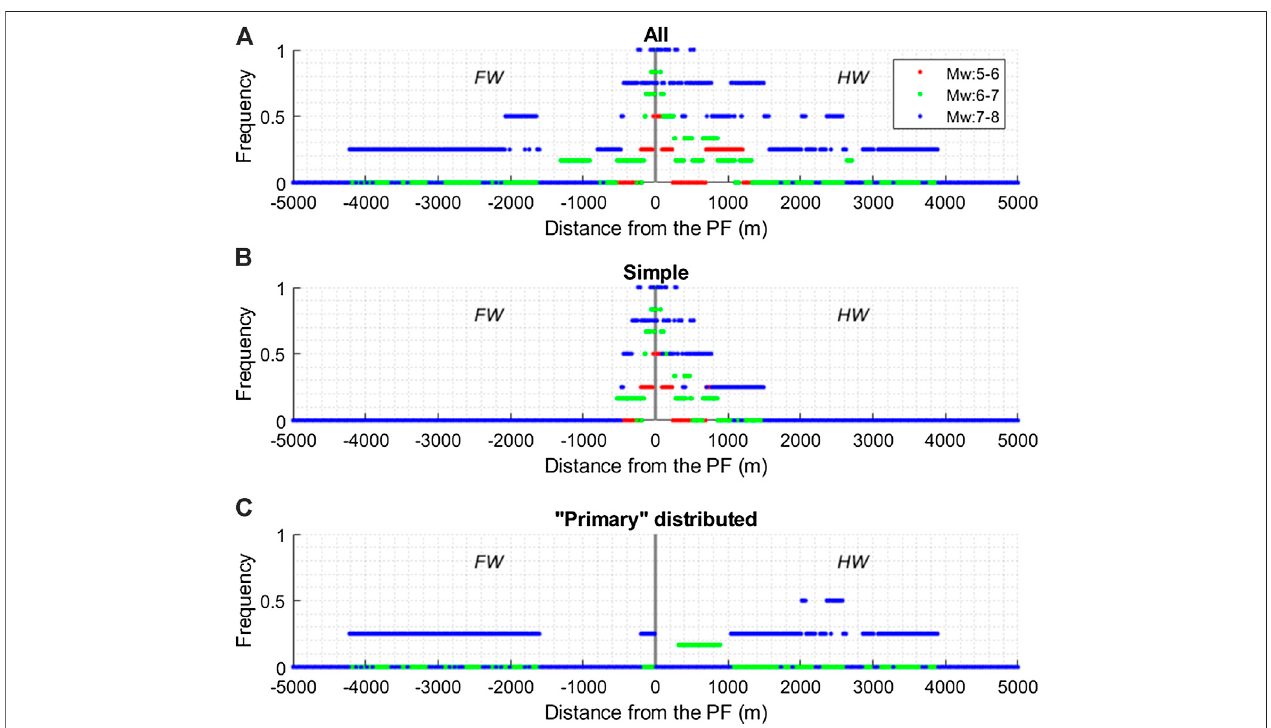
FIGURE 5 | Frequency of distributed rupturing as a function of the distance r from the PF for three classes of magnitude considering (A) all types of DR, (B) only simple DR (ranking 2), or (C) only “ Primary ” distributed rupturing (ranking 1.5) on footwall (FW) and hanging wall (HW) sides.